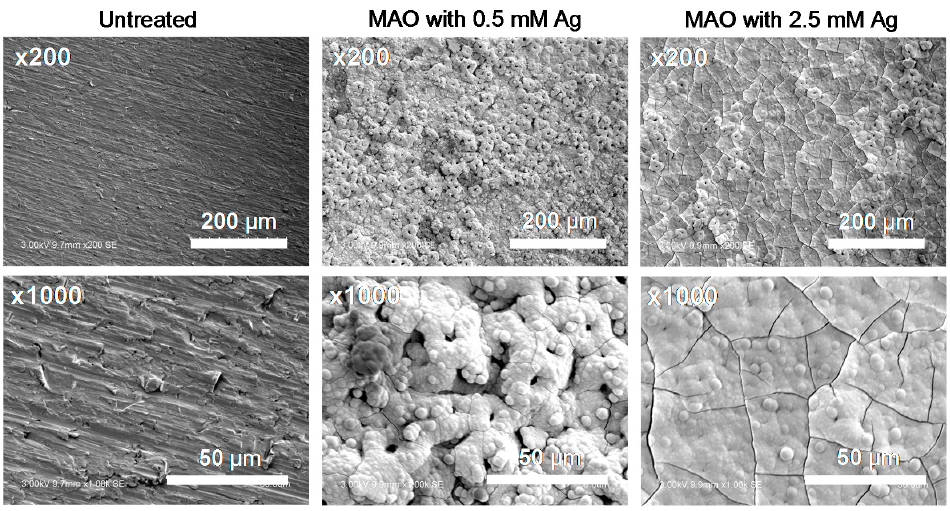
Figure 4. Scanning electron micrographs of specimens after immersion in Hanks ʹ solution for 7 days.